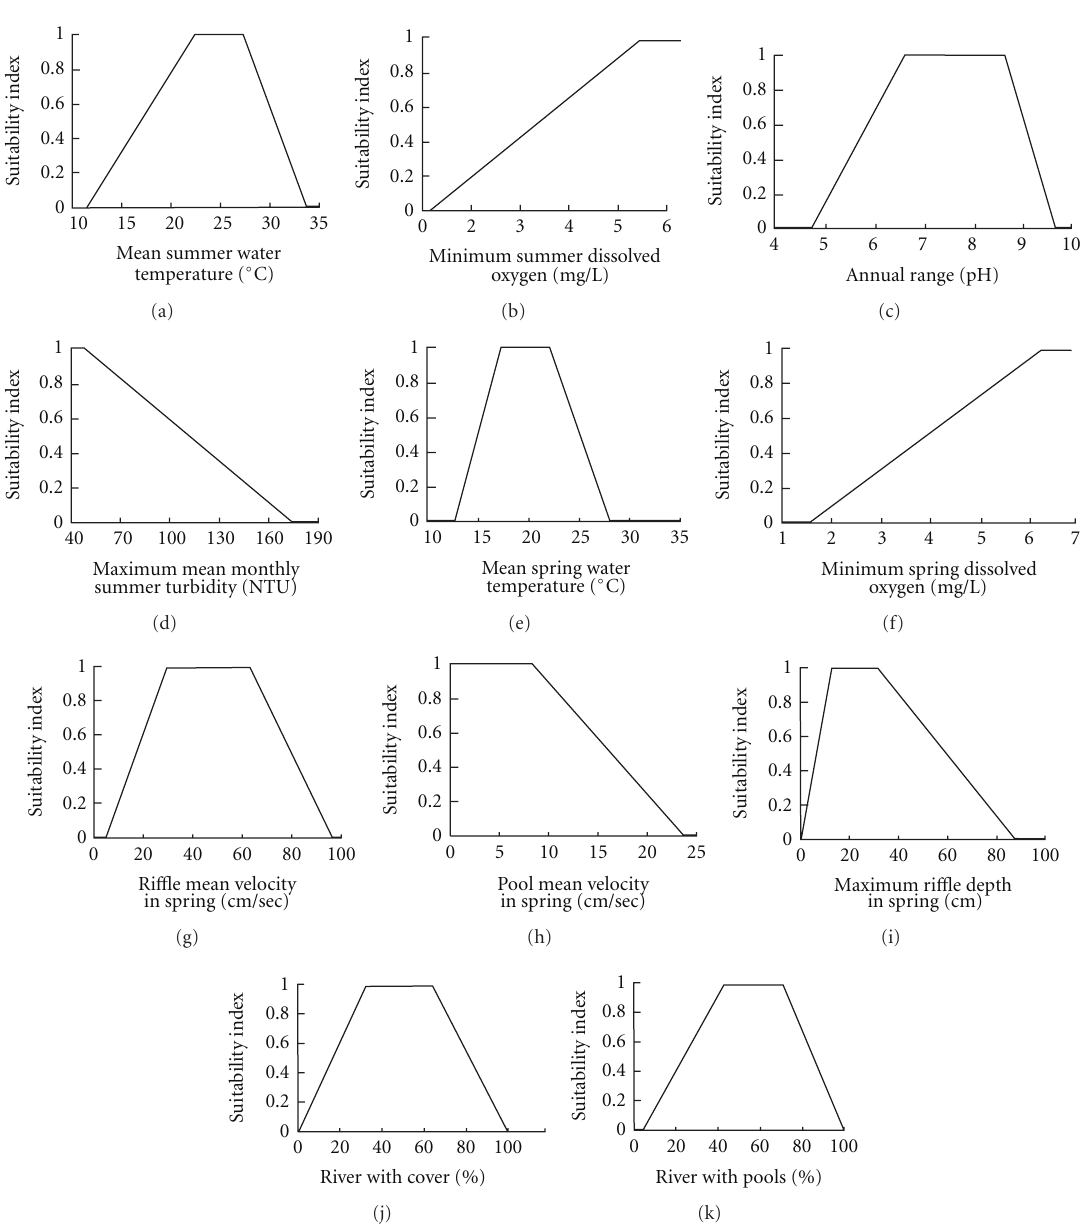
Figure 1: Suitability index plots of 11 variables shown with a tolerable range (0 points on the Y -axis) and optimal range (1 values on the Y -axis) for each variable. Panel plots are cross referenced in Table 2 where more detailed definitions of the variables are